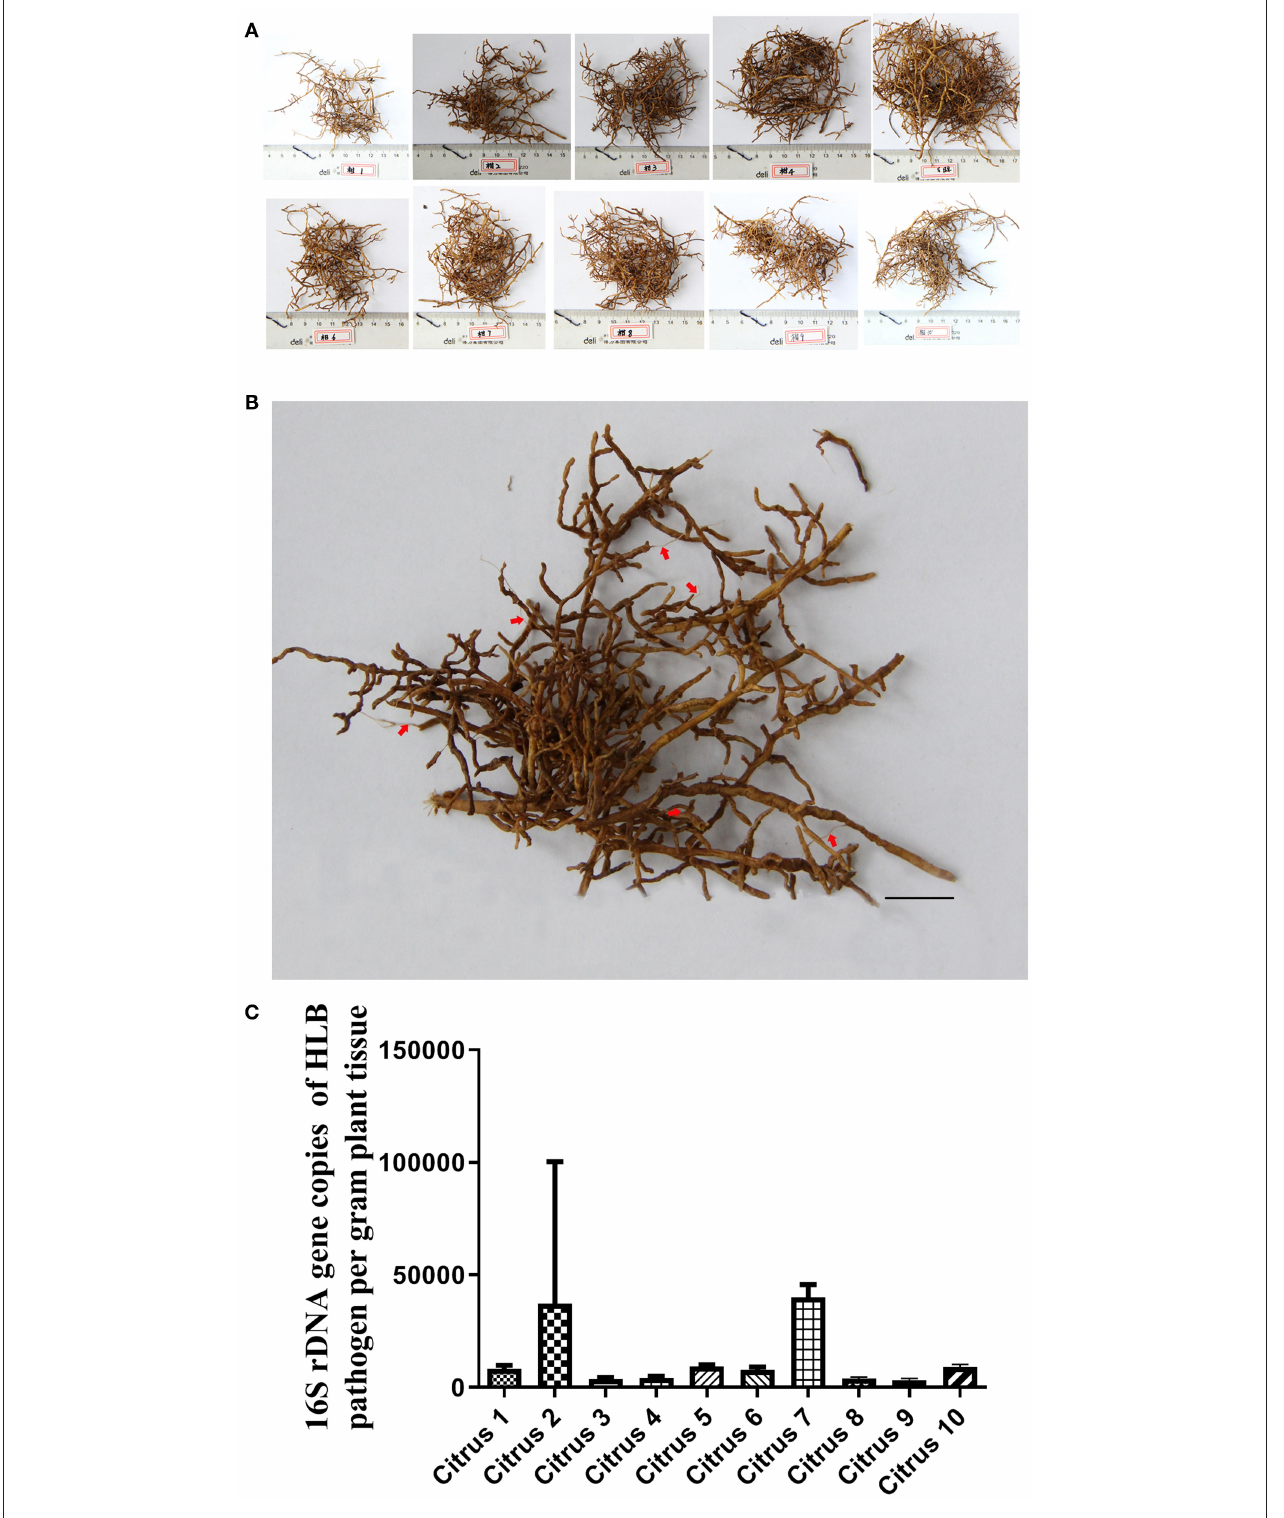
FIGURE 2 | Root lesion phenotype in citrus trees with slight HLB infection. (A) visual appearance of mildly HLB-infected tree roots. (B) detail of one root system presented in (A) . Red arrows indicate lesions with tissue degradation and exposed xylem (Scale bars = 10mm.) (C) HLB bacterial population in leaf midrib samples from plants corresponding to (A) . And the standard curve used is 16S rDNA gene copies of Ca. Las per gram leaves midrib corresponding to (A) , Y = − 0.286X + 11.924, Y represents 16S rDNA gene copies of HLB pathogen, X represents Ct value. These data consistent with Supplementary Table 2 .